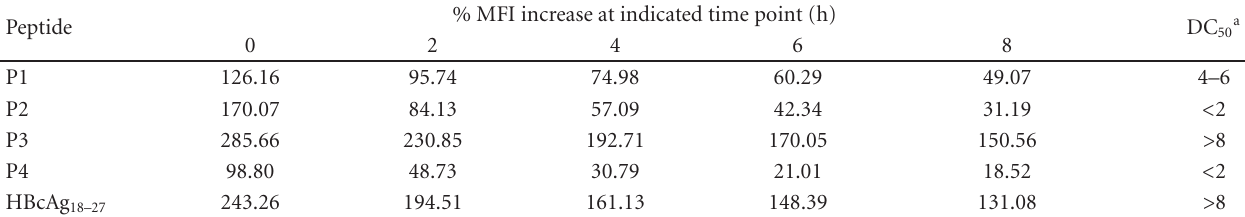
Table 2: HLA-A ∗ 0201 stabilization capacity of candidate epitope